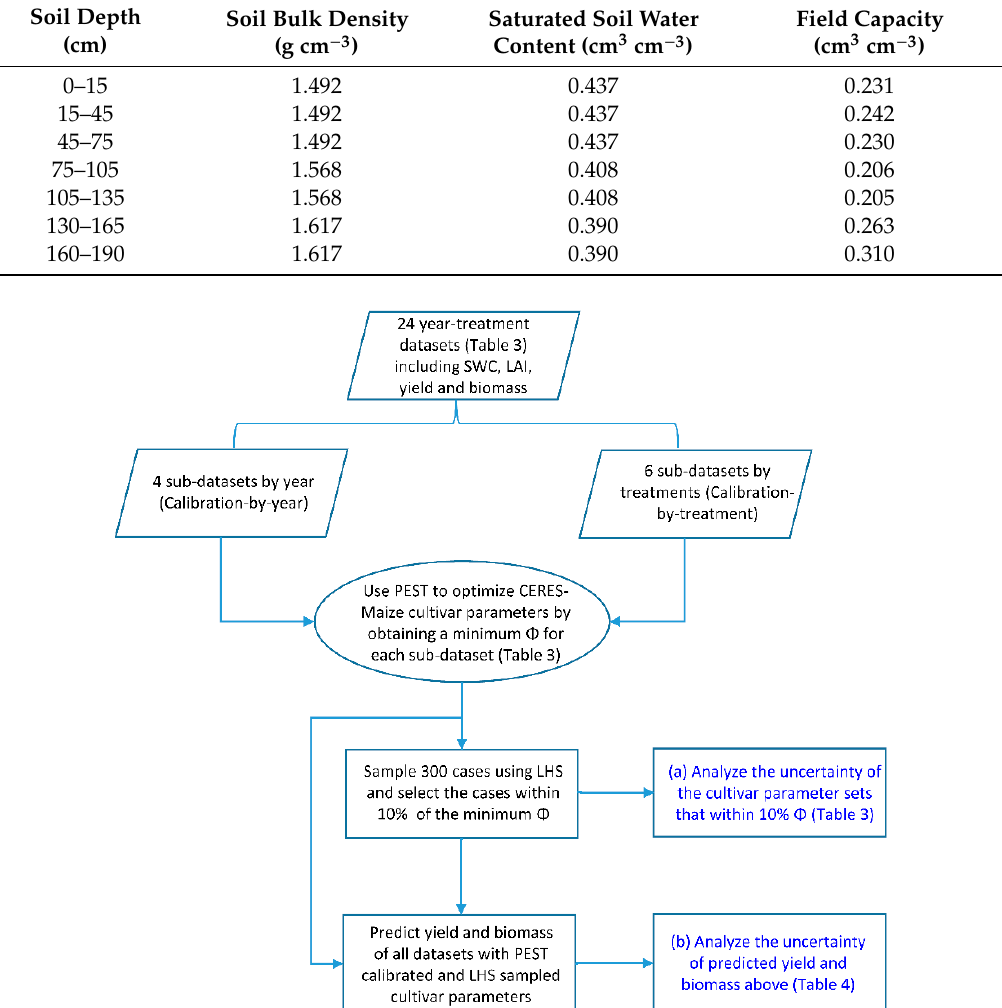
Table 2. Soil horizon, soil bulk density, saturated soil water content, and calibrated field capacity used in previous studies [6,33].